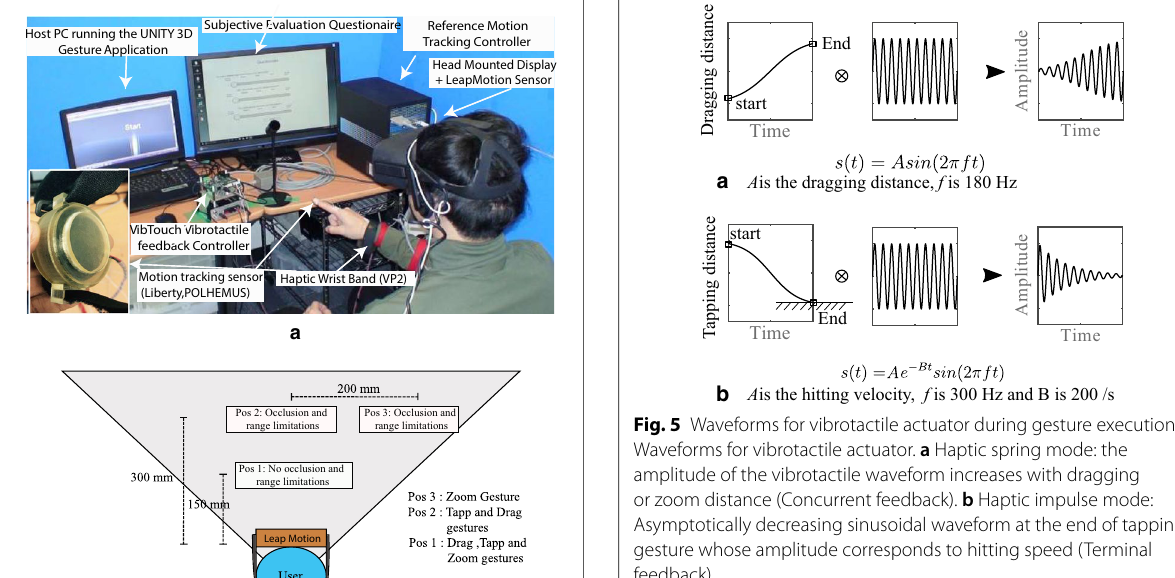
A is the dragging distance, f is 180 Hz